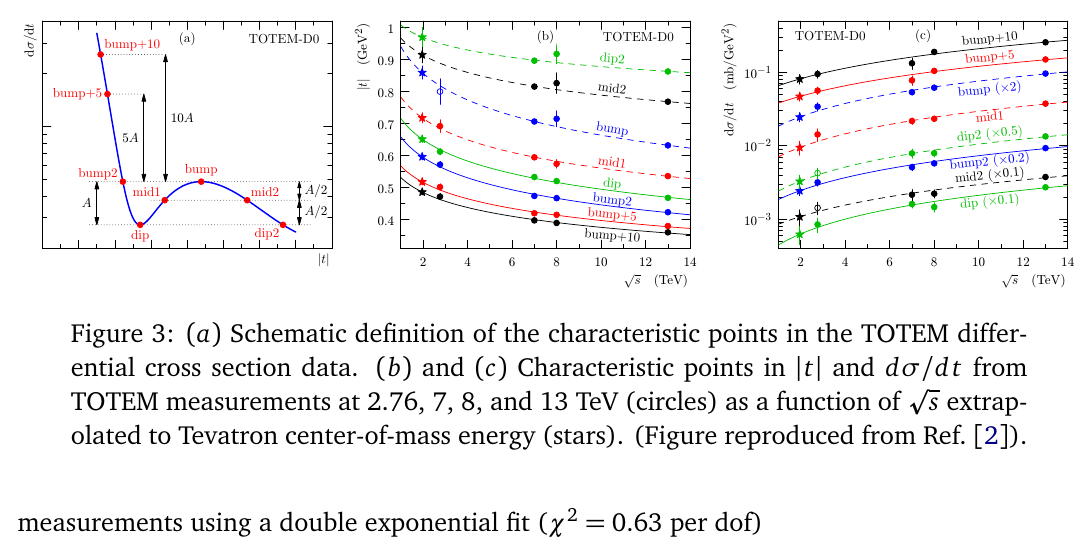
(cid:112) s extrap-